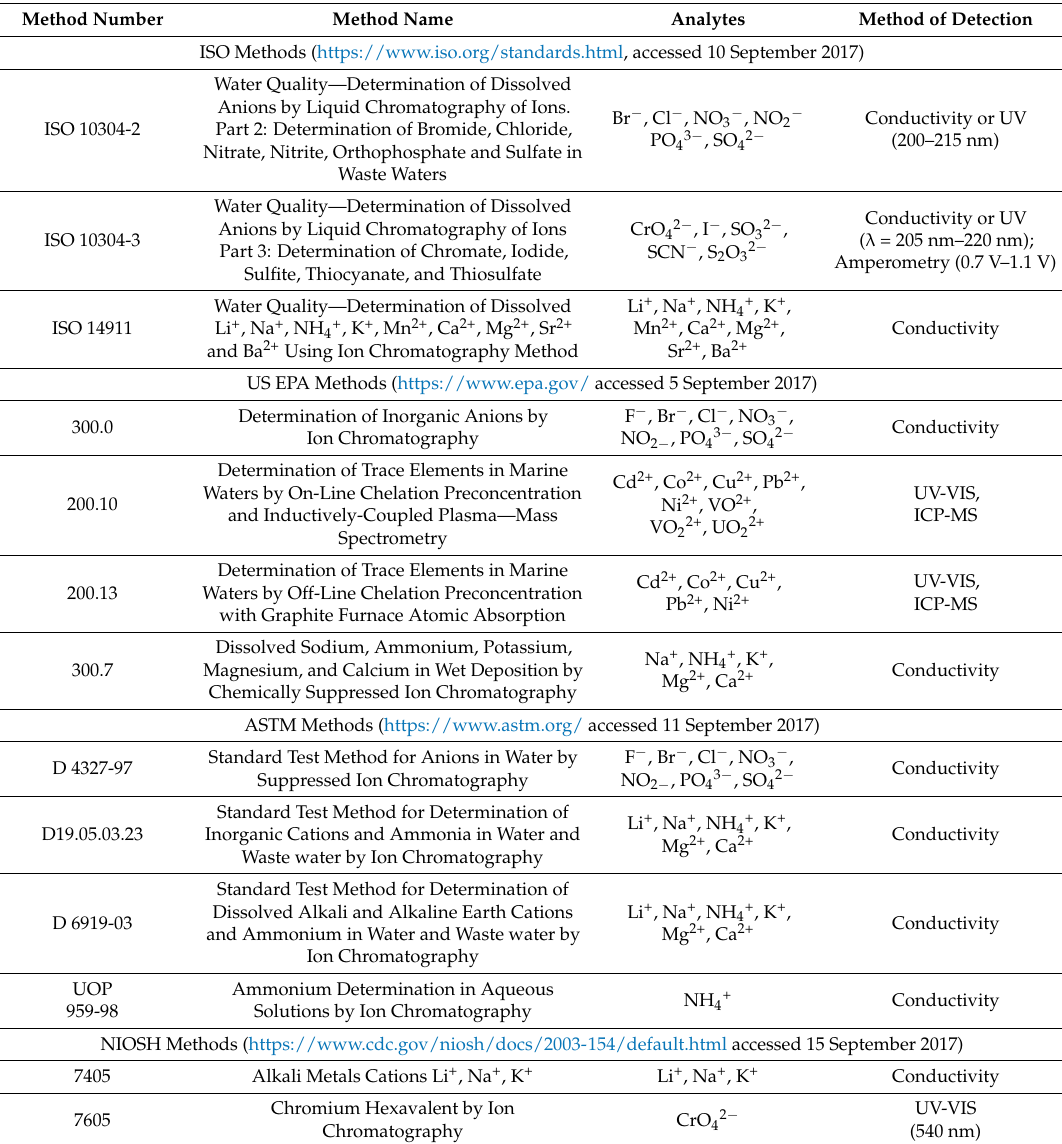
Table 3. An examples of ion chromatography methods for inorganic and organic ions analysis in waste water established by ISO, US EPA, ASTM and